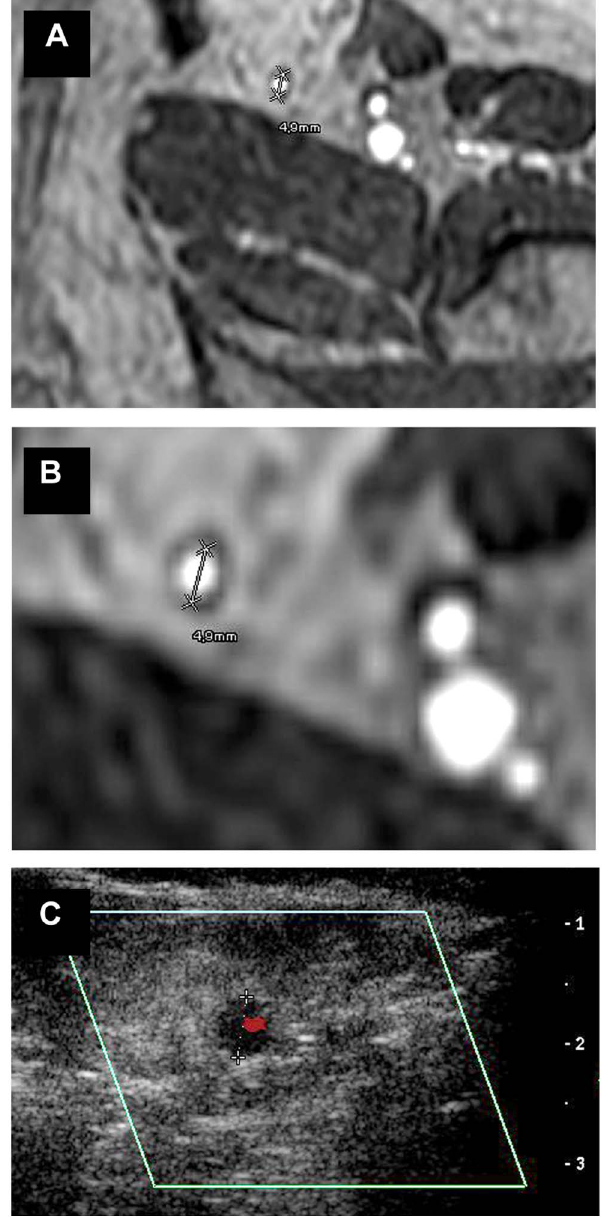
Figure 4. MR-angiographic and duplex sonographic images of the great saphenous vein. Magnetic resonance imaging (BPCA-MRA) and color-coded duplex sonography in the distal level of the left GSV in a 69 year old male patient with PAOD stage IV. (a, b) Axial multiplanar reformat of contrast-enhanced T1-weighted gradient-echo images during the steady-state. (c) Axial color-coded duplex sonography. level of the common iliac arteries by means of fluoroscopic triggering, the acquisition of first pass images was started. The imaging protocol as well as technical parameters of the T1- weighted gradient-echo sequences that were used for first-pass and steady-state MR angiography are shown in figure 2 [31], [35]. Steady-state imaging followed first-pass imaging 4 minutes after contrast injection [36].